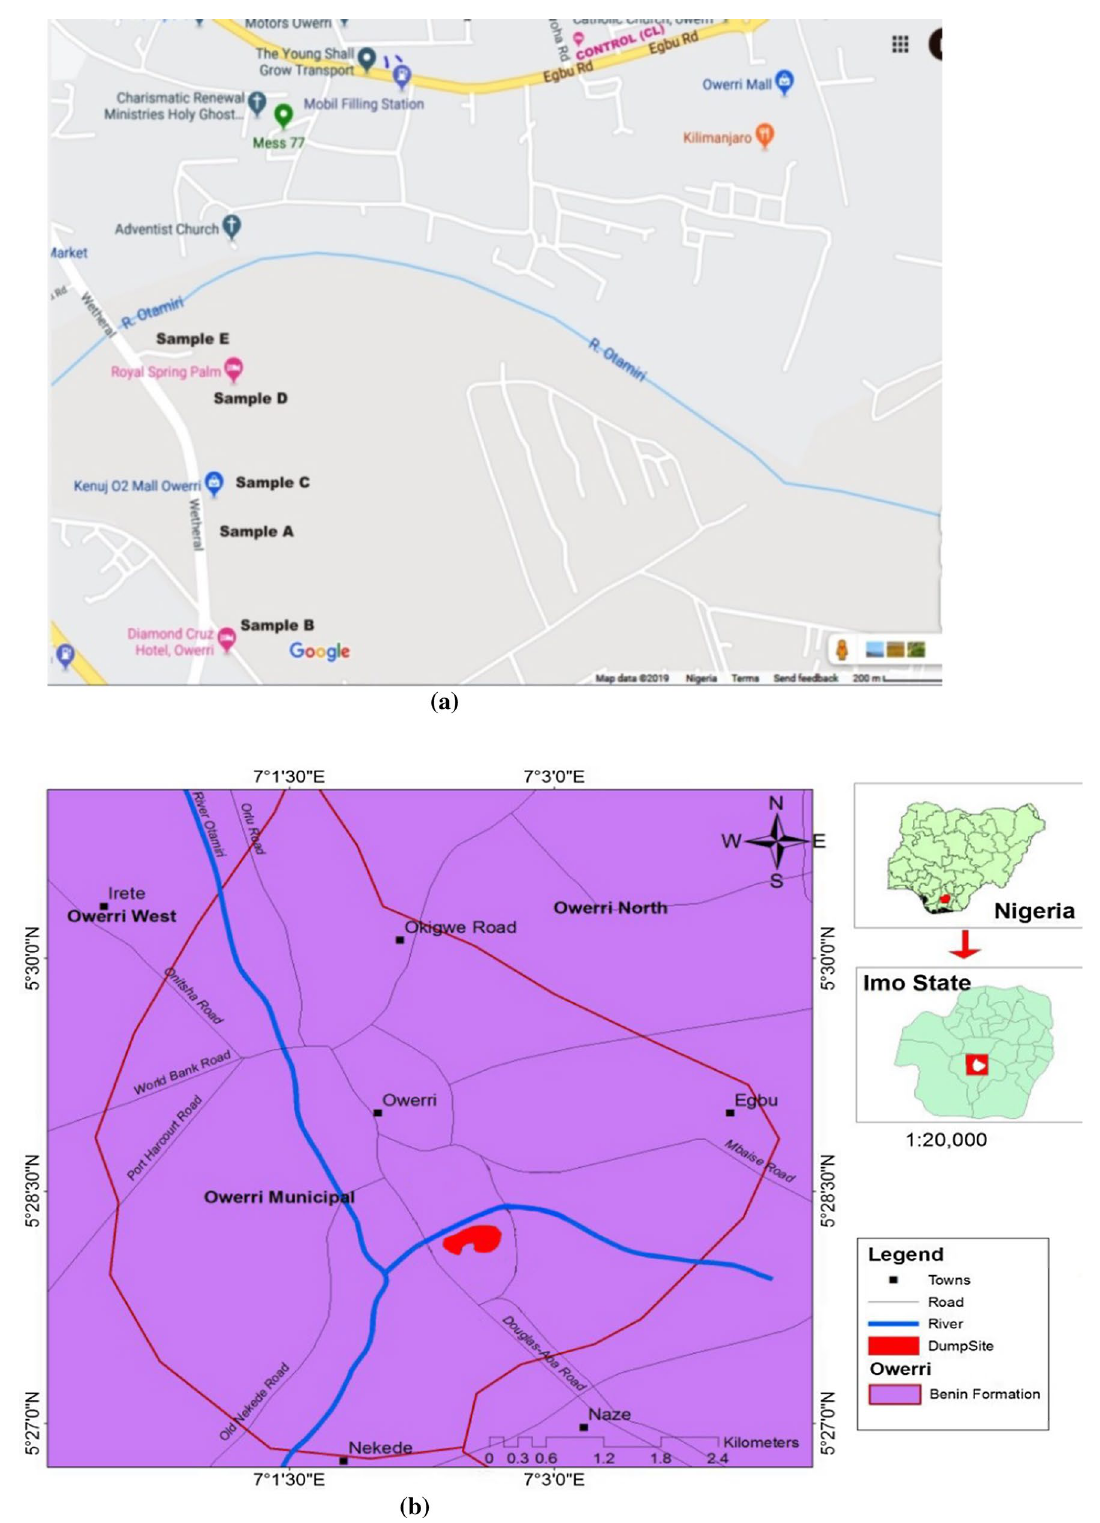
Fig. 1 a Google map of study location. b Geological map of Owerri and environs showing the reclaimed dumpsite. *Ibe et al.